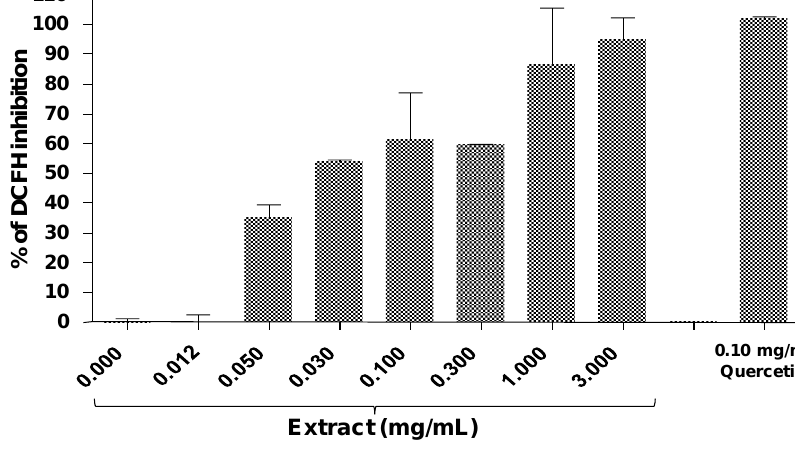
Figure 1. Effect of various concentration P.grandis (stem bark) methanolic extract on oxidative stress induced by 10 − 4 M tBuOOH. Quercetin (0.1 mg/mL) was used as positive control.